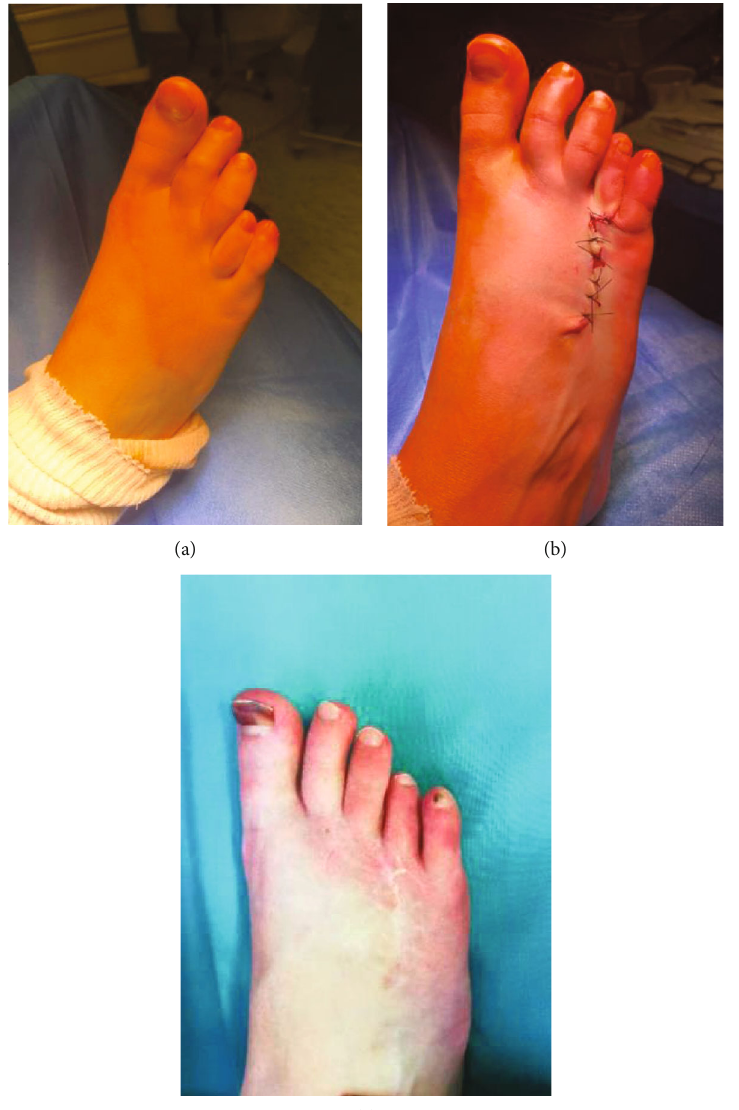
Figure 4: Case 1. (a) Preoperative photography. (b) Postoperative photography after closing the Z-plasty. (c) Photography of the lengthening at 12-month